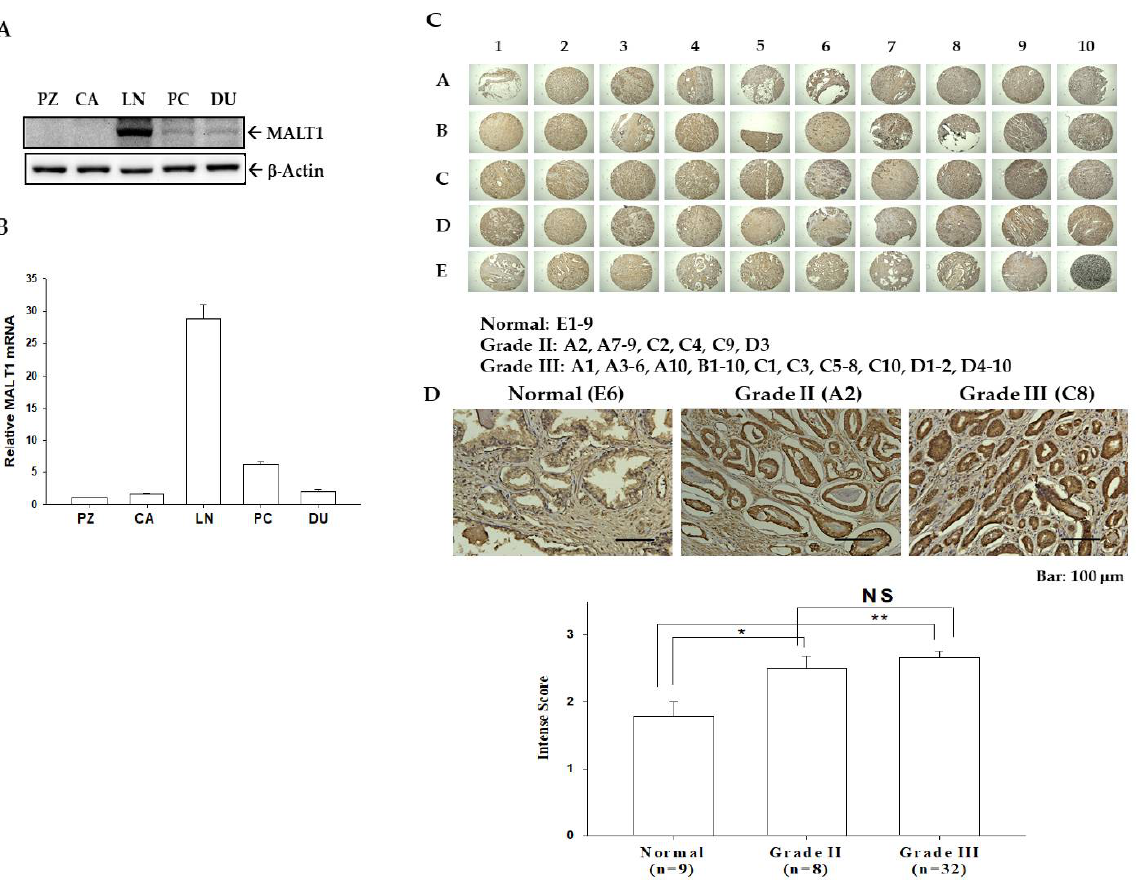
Figure 1. Expression of MALT1 in prostate carcinoma cells and prostate tissues. MALT1 expression in human prostate cells (PZ: PZ-HPV-10, CA: CA-HPV-7, LN: LNCaP, PC: PC-3, DU: DU145) was determined by ( A ) immunoblot and ( B ) RT-qPCR assays. ( C ) MALT1 expression levels were determined by IHC staining in human prostate tissue array with normal and cancer tissues. ( D ) The enlarged figures of normal, grand II, and grade III were shown in the top panel, and the intense score of MALT1 in normal ( n = 9) or cancer tissues (grade II, n = 8; grade III, n = 32) were determined by IHC staining. * p < 0.05, ** p < 0.01, NS represents no significance.